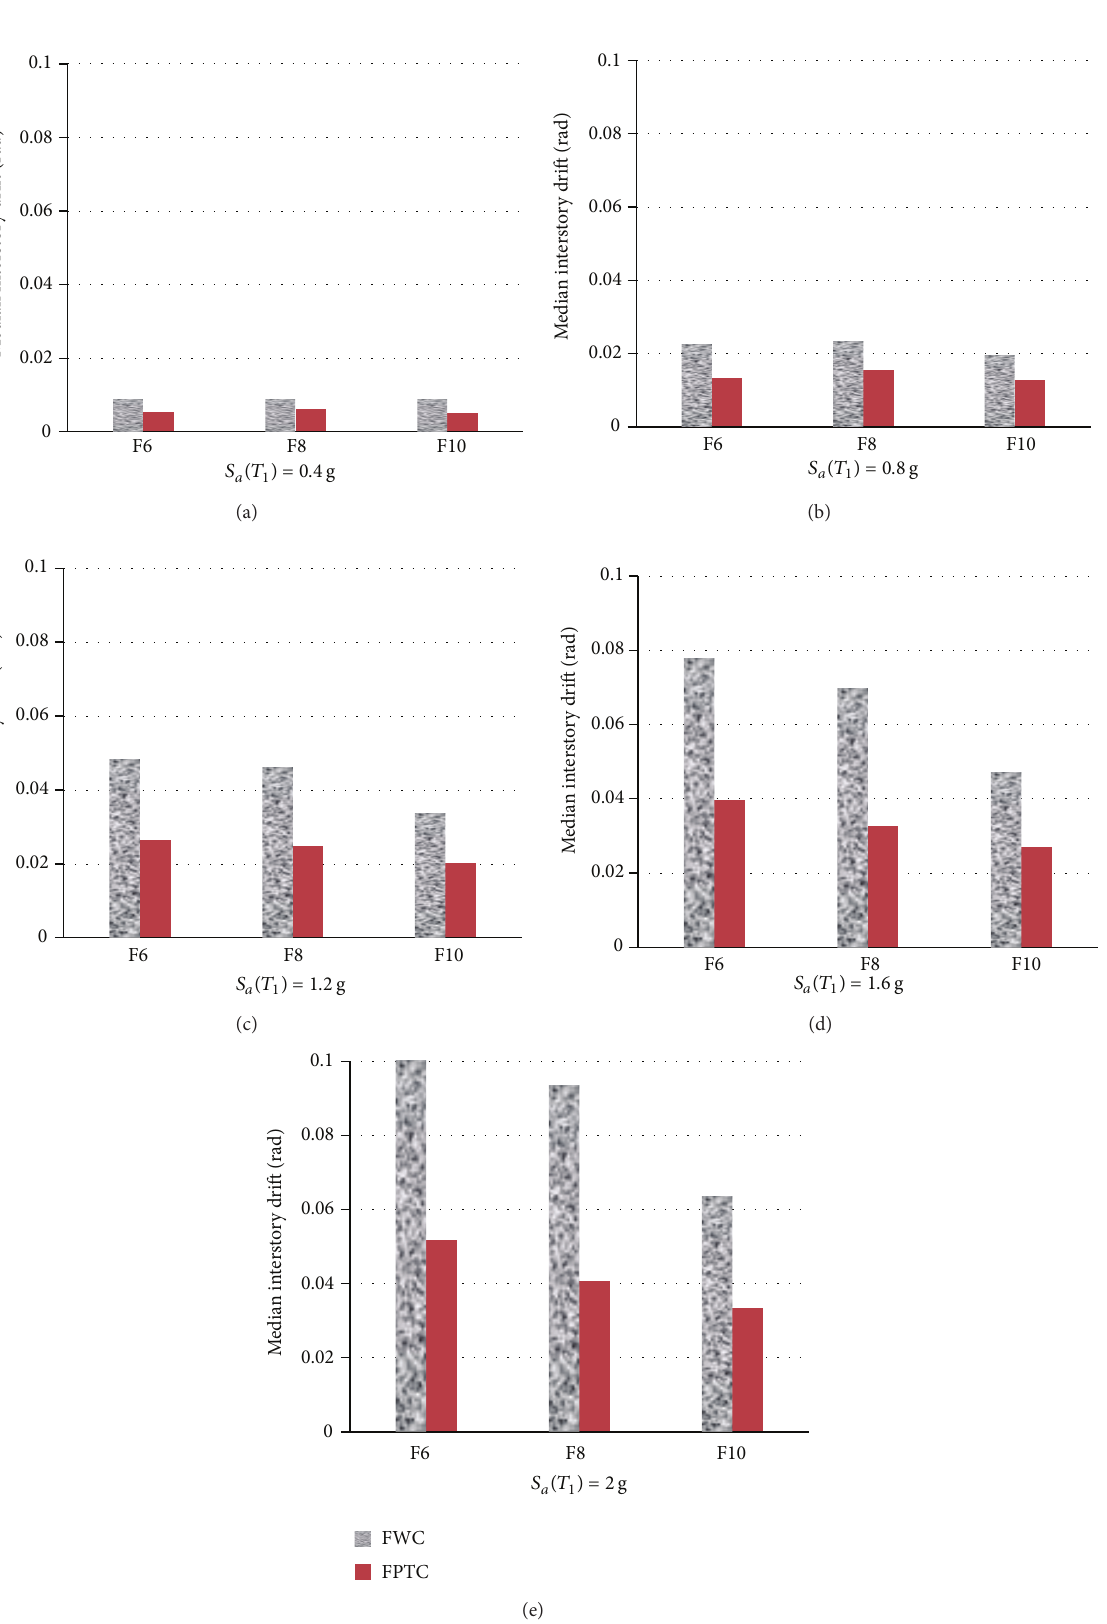
Figure 6: Median of maximum interstory drift of the frames FWC and